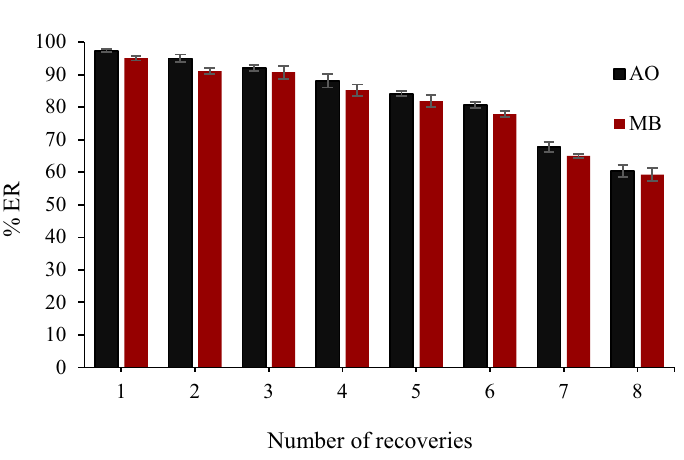
Figure 6. Regeneration studies of magnetic MgO-NPs (Sample volume: 10 mL, eluent volume: 225 µL, adsorbent mass: 0.025 g, sonication time: 5 min, and pH: